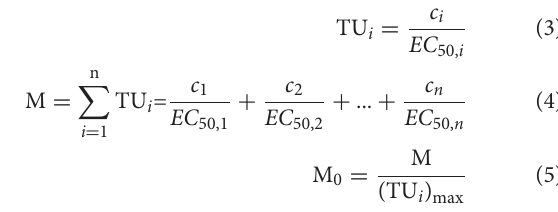
FIGURE 3 | equivalent effect picture of joint toxicity. With different toxic ratios, the isobologram method may yield distinct joint effects (Ding et al., 2015). (C) Isobologram of TMAH and KI mixture. The solid straight line indicates theoretical additive toxicity. Dot lines indicate 95% confidential interval of the theoretical additive effect (Mori et al., 2015). (D) The theoretical isobologram of the combination of three substances (Huang et al., 2019b). (E) Isobologram for a mixture of fullerene soot and nonylphenol (Sanchis et al., 2016). (F) Isobologram for a mixture of fullerene soot and triclosan (Sanchis et al., 2016). (G) Isobologram for the mixture of fullerene soot and malathion (Sanchis et al., 2016). (H) Isobologram for the mixture of fullerene soot and glyphosate (Sanchis et al., 2016). Adapted and modified with permission from Ding et al. (2015), Mori et al. (2015), Huang et al. (2019b) and Sanchis et al.